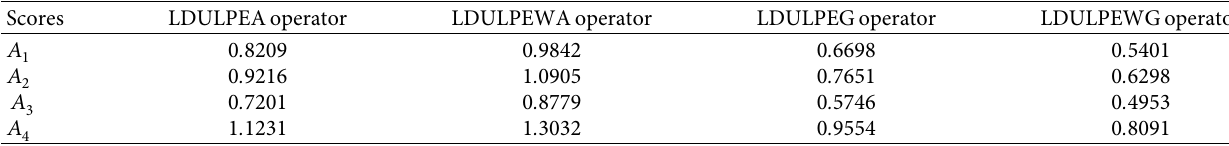
Table 3: Score values of the aggregated operators.